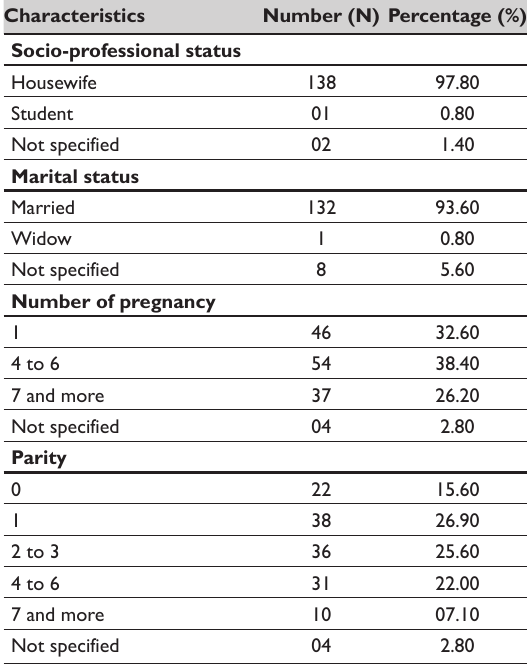
Table I: Distribution of maternal death cases in Dori Hospital, Burkina Faso, according to socio-professional status, marital status, number of pregnancies and parity, 2014 to 2016 (n=141).